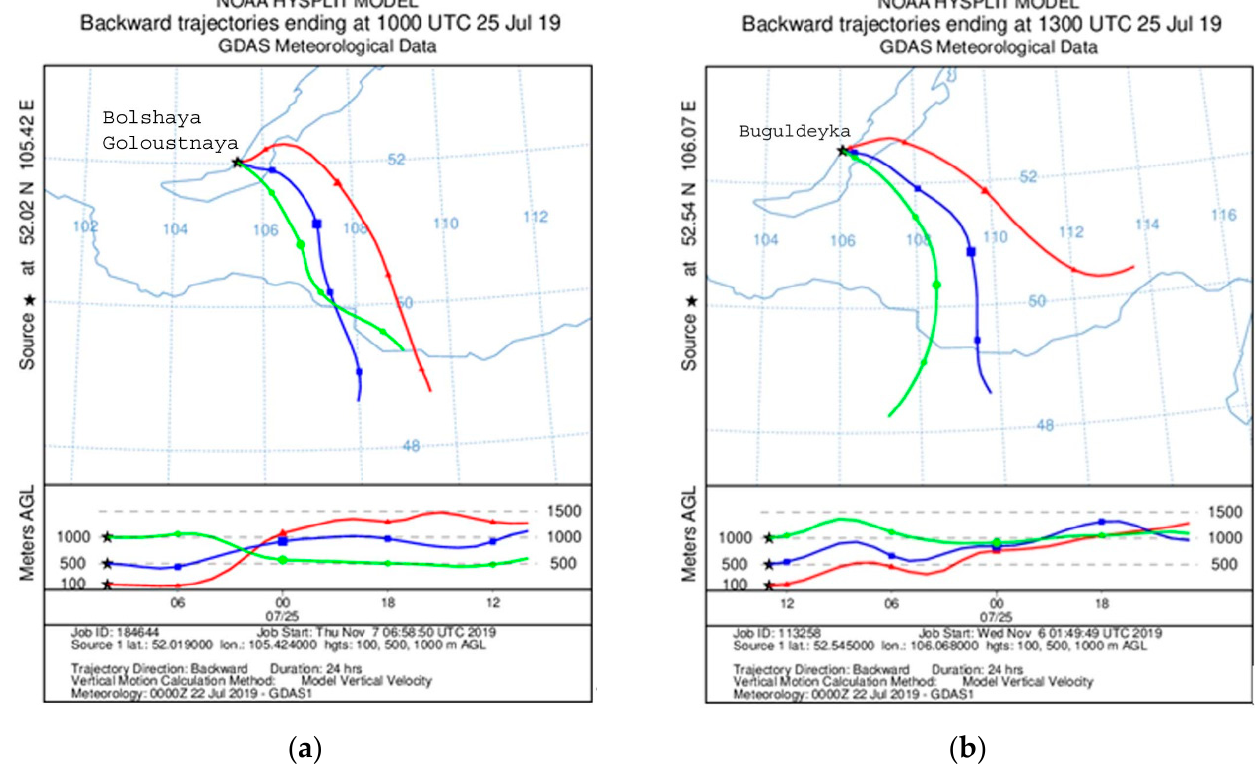
Figure 5. Backwards trajectories of air masses transfer according to the HYSPLIT model: ( a ) Bolshaya Goloustnaya; ( b ) Buguldeika. The paths for the transfer of air masses trajectory at three altitude levels: 100 m (red color), 500 m (blue color) and 1000 m (green color).